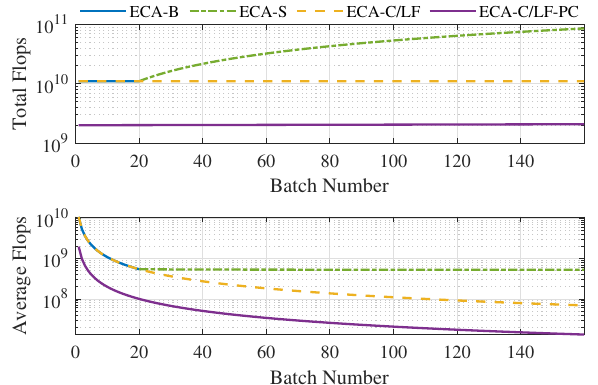
Figure 3. Total and average Flops of different ECA